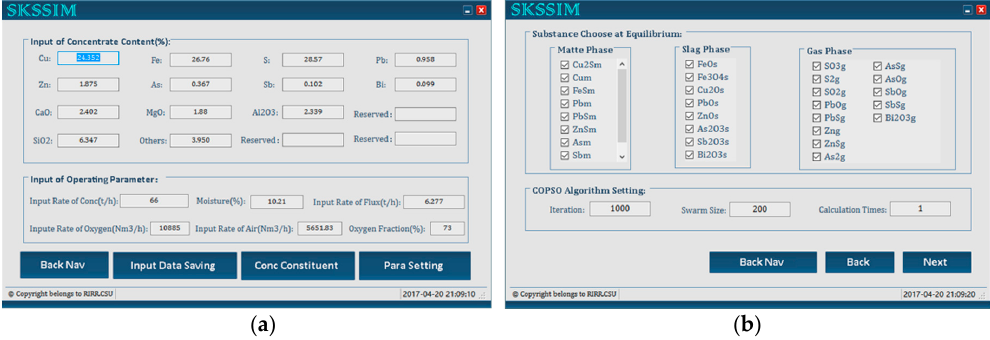
Figure 5. Input interfaces in the steady working condition: ( a ) calculation condition; ( b ) algorithm parameters.